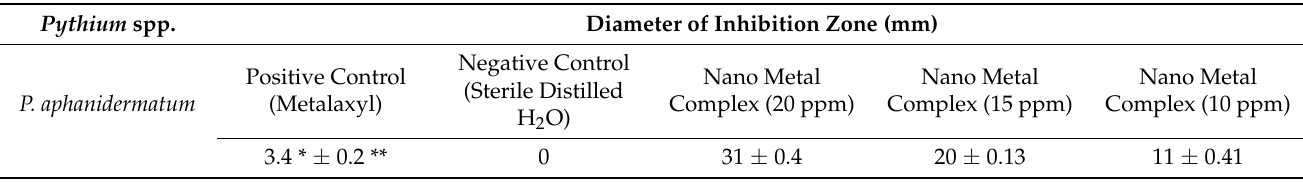
Table 5. Antifungal activity of nano-metal complex against P. aphanidermatum on PDA medium at 26 ◦ C for 6 days in the dark. Pythium